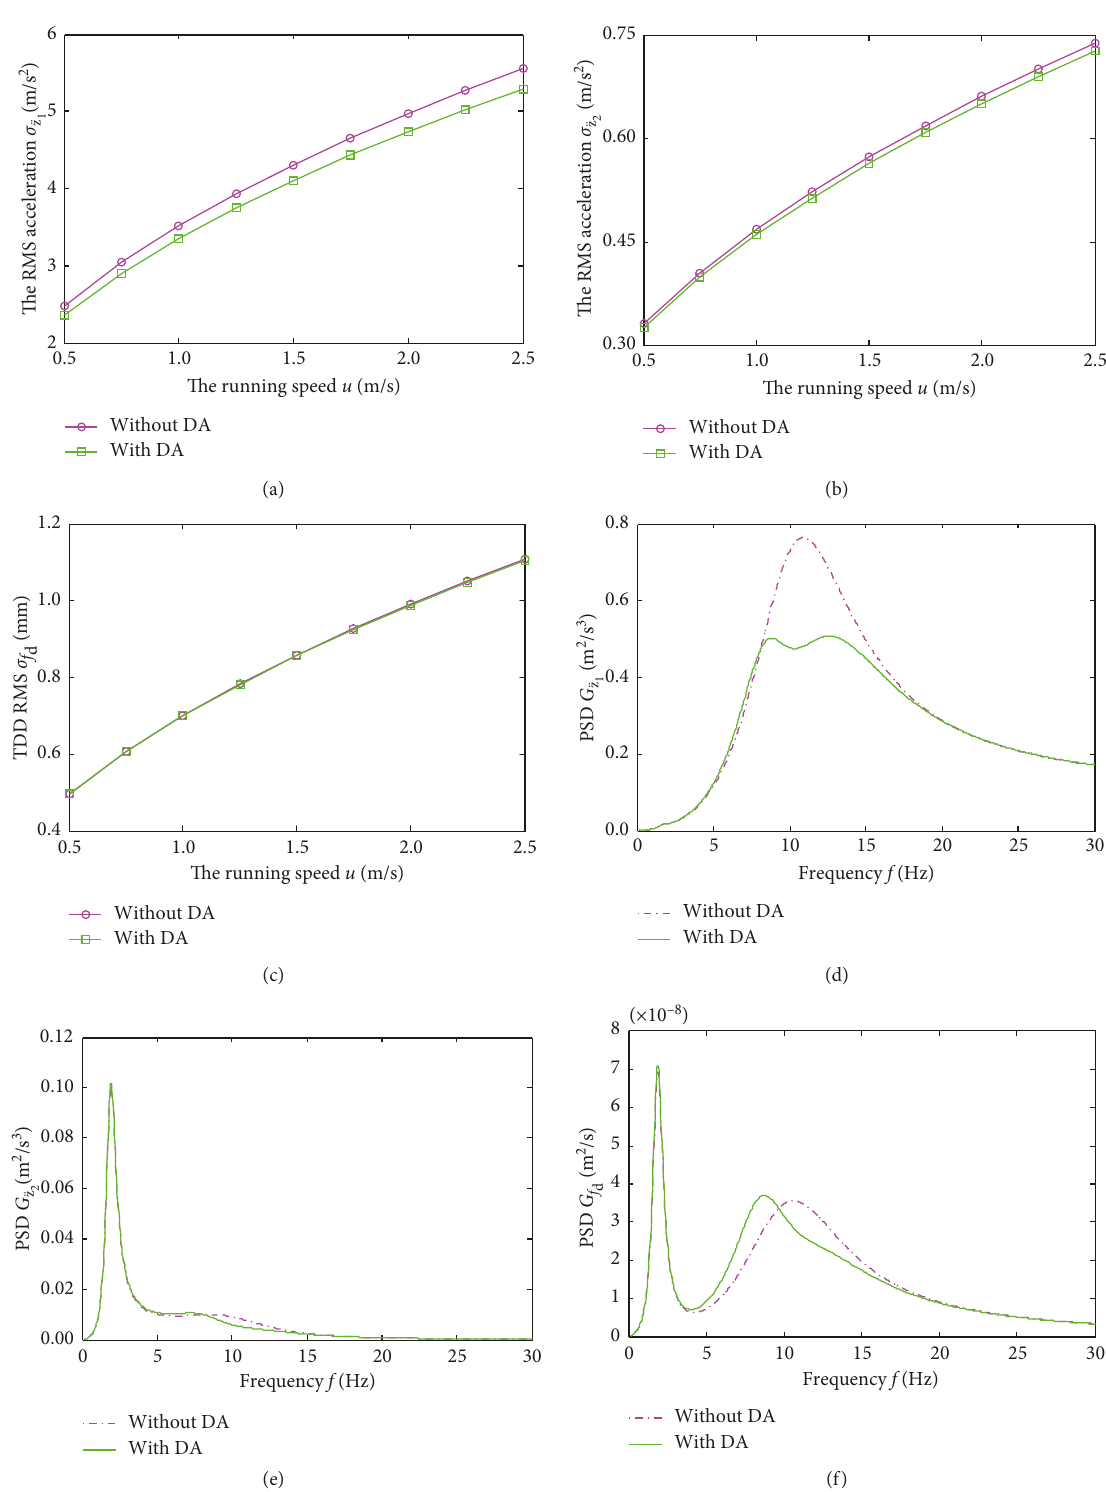
Figure 3: A comparison of the dynamic responses calculated from the vibration models of the convalescent-wheelchair with DA and without DA: (a) the wheelchair body RMS acceleration σ € z running speed u ; (c) the TDD RMS σ f (e) the convalescent acceleration PSD G € z